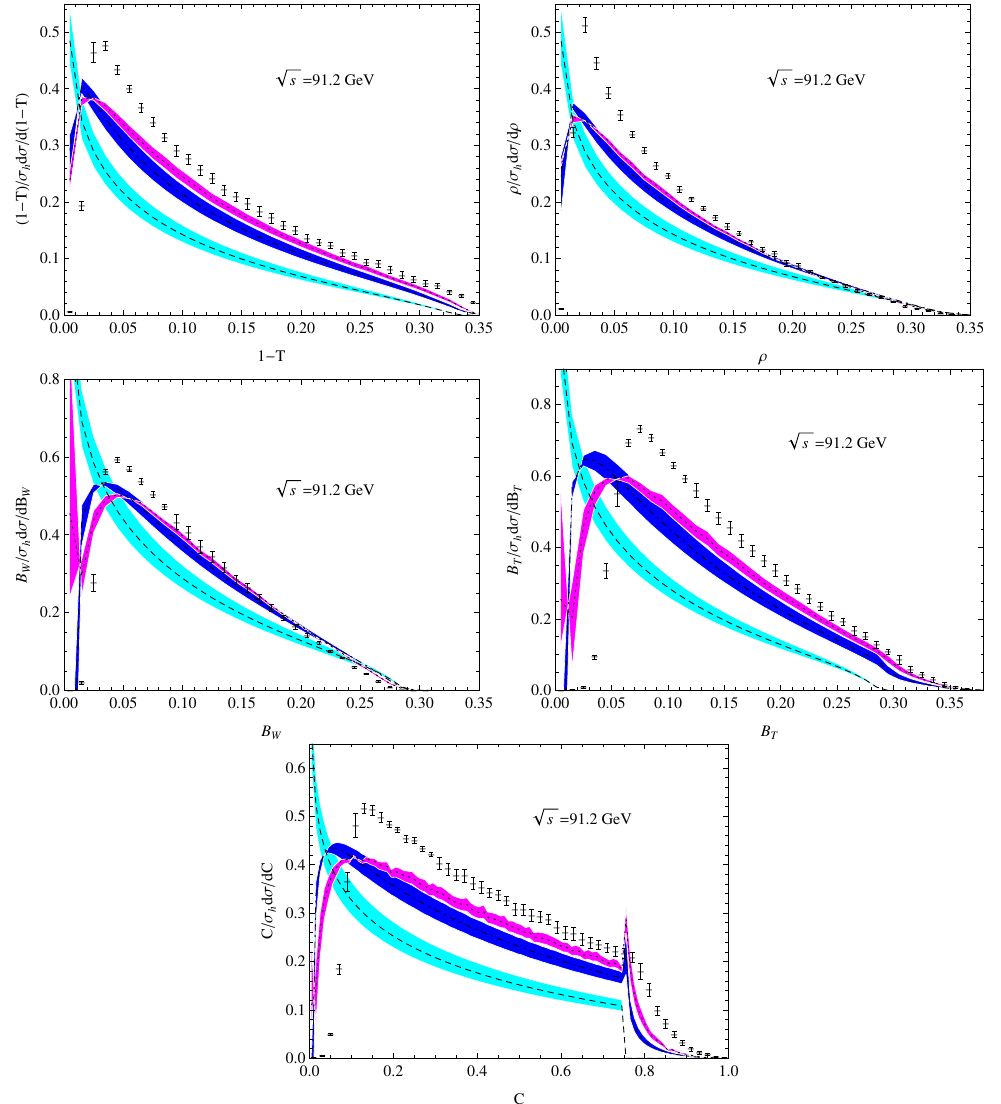
Figure 1. The event shape observables thrust ( 1 − T ), heavy jet mass ( ρ ), wide jet broadening ( B ), total jet broadening ( B ) and C-parameter ( C ) using the conventional scale-setting method W T √ at s = 91 . 2 GeV. For all the figures, the dashed, dotdashed and dotted lines are the conventional results at LO, NLO and NNLO [13, 16], respectively. The bands for the theoretical predictions √ √ are obtained by varying µ [ s/ 2 , 2 s ] . The experimental data are taken from the ALEPH r ∈ Collaboration